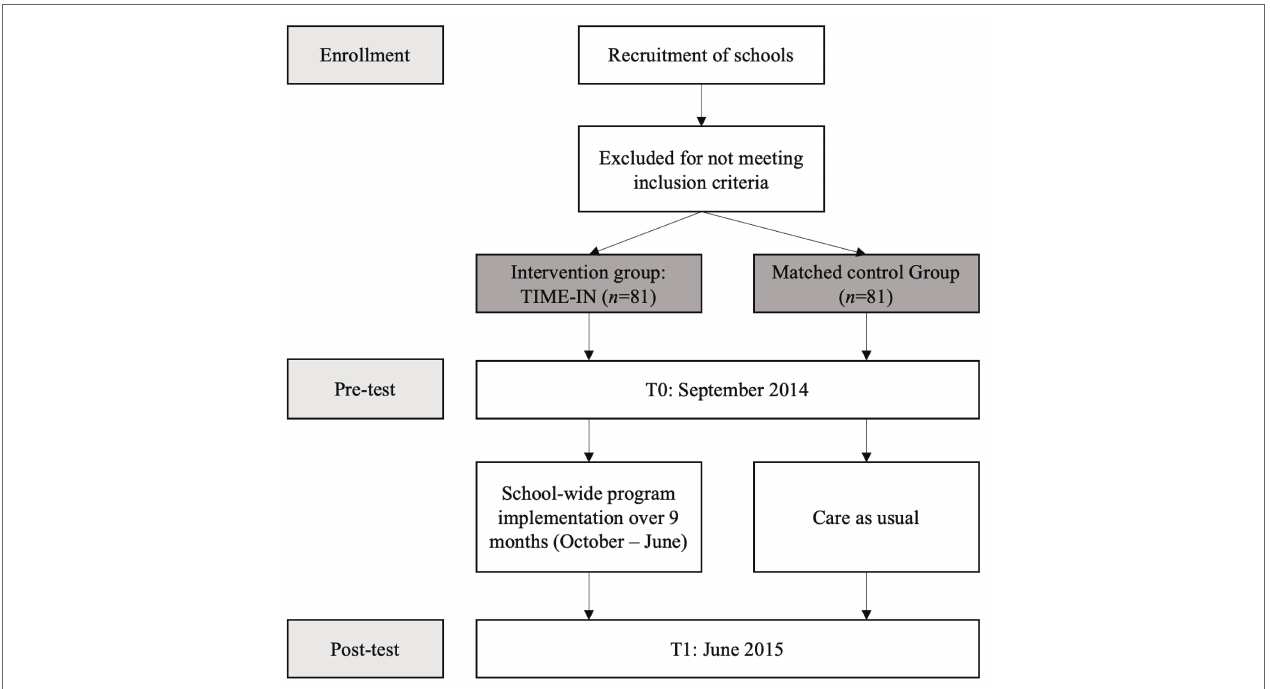
FIGURE 1 | TIME-IN study design. Study progress from enrollment, pre-test to